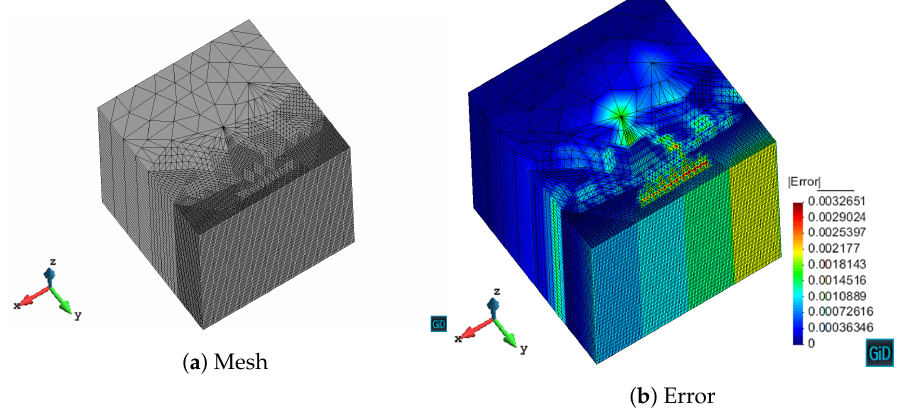
Figure 6. Refinement with a criterion for not allowing elements with an angle lower than 0.4 rad.